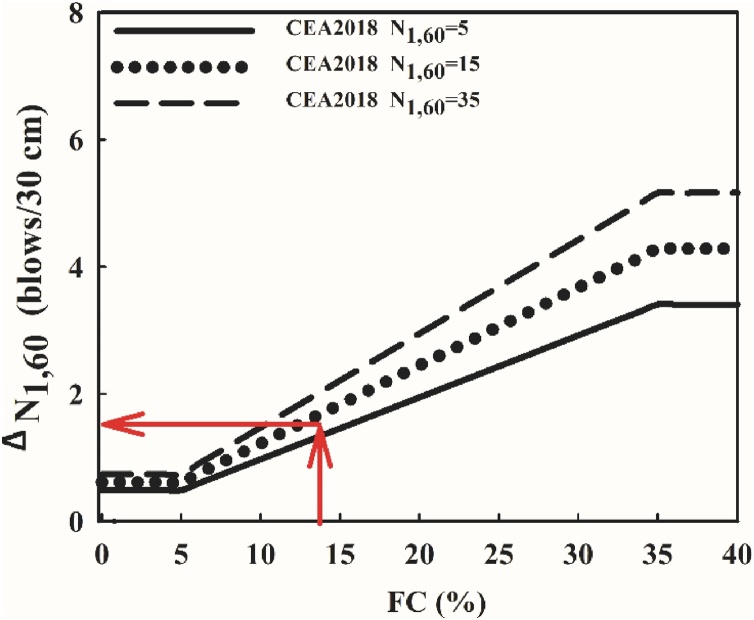
Proposed N1,60 dependent fines correction.